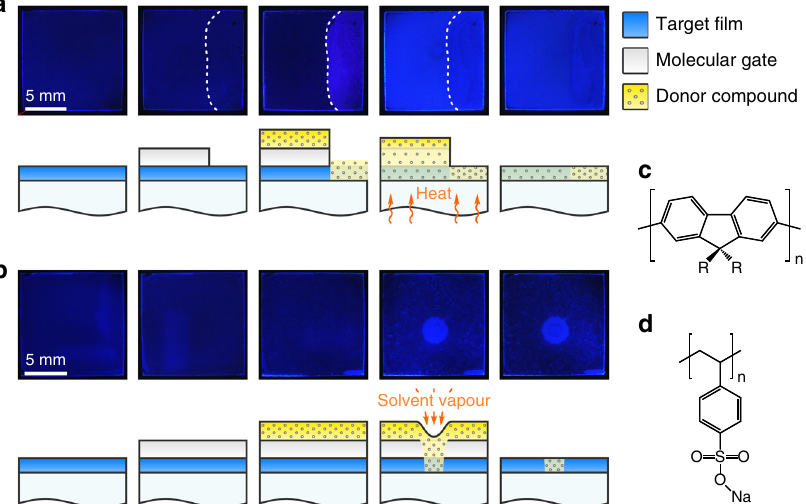
Fig. 1 Illustration of the molecular-gate concept by PL switching in PFO fi lms. Examples are shown for ( a ) thermal and ( b ) solvent-vapour-based stimuli. Top rows show photographs of the fi lms under UV light illumination at the sequential processing steps, depicted schematically in the bottom rows. These are: deposition from solutions of the target fi lm (PFO; depicted in blue), the ‘ molecular gate ’ (pNaSS; depicted in grey) and the functional donor compound (lauric acid; depicted in yellow + grey circles); followed by application of heat or solvent vapour to diffuse lauric acid into the PFO fi lm via the molecular gate and, fi nally, removal of the residual donor layer and gate by spin-off. In the second step of ( a ), a part of the gate was removed by immersion in water (as shown by the dotted line) to highlight its role in preserving the ‘ baseline ’ characteristics of the target fi lm during donor layer deposition. Also shown are the chemical structures of ( c ) PFO ( R = C 8 H 17 ) and ( d )